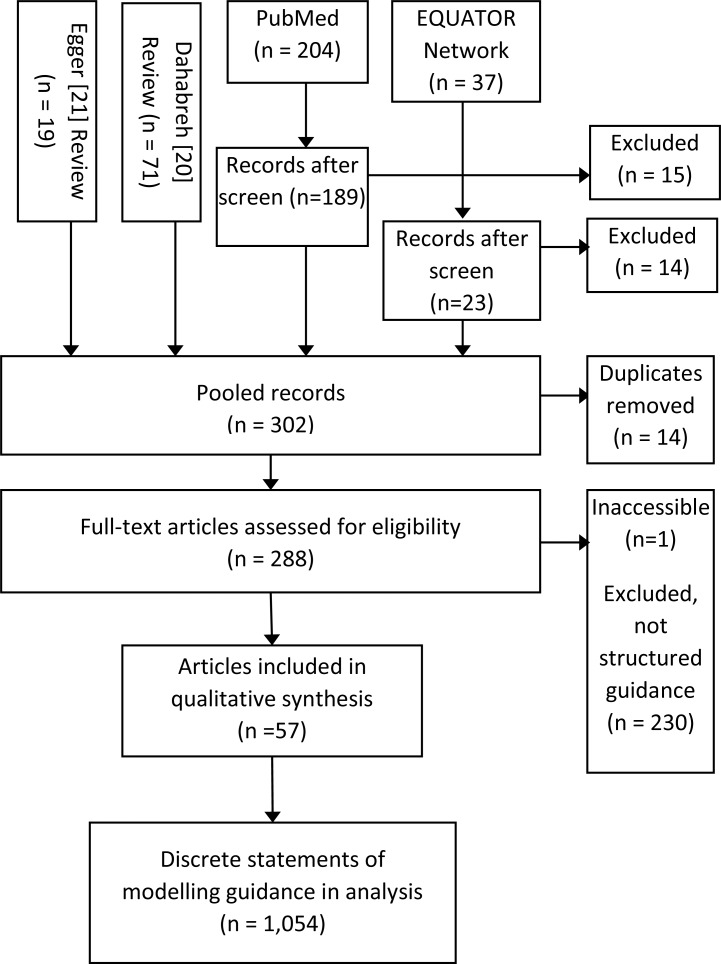
Study selection.